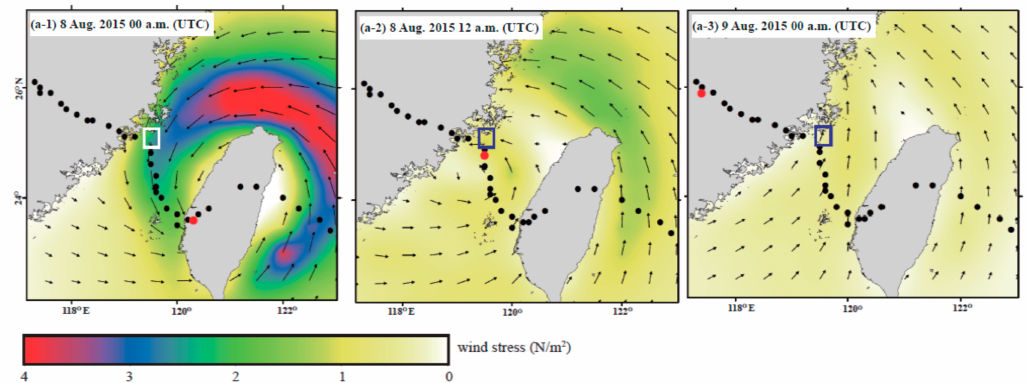
Figure 4. Distributions of wind stress in the Taiwan Strait on ( a-1 ) 8 August 2015 00 a.m.; ( a-2 ) 8 August 2015 12 a.m.; and ( a-3 ) 9 August 2015 00 a.m. The black dotted line in the figures shows the track of Typhoon Soudelor, and the red dot shows the location of the typhoon center at a given